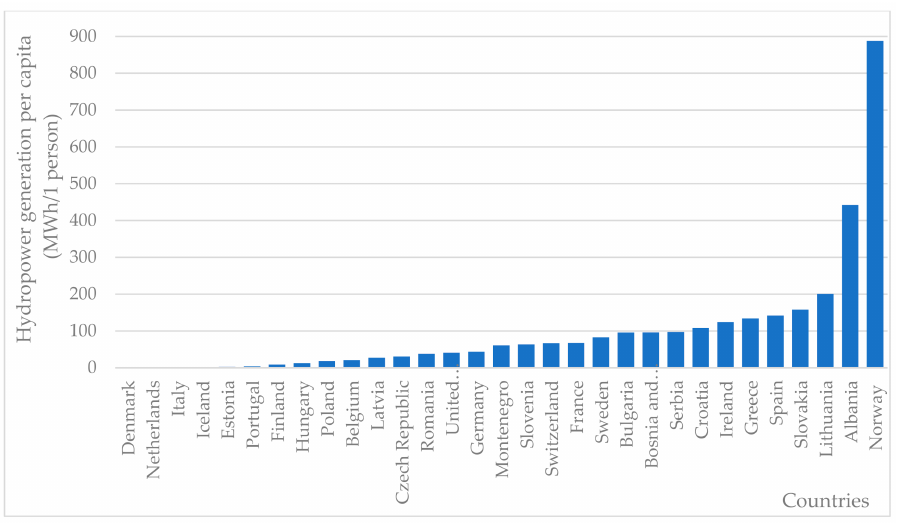
Figure 2. Hydropower generation per capita in selected European countries (data based on